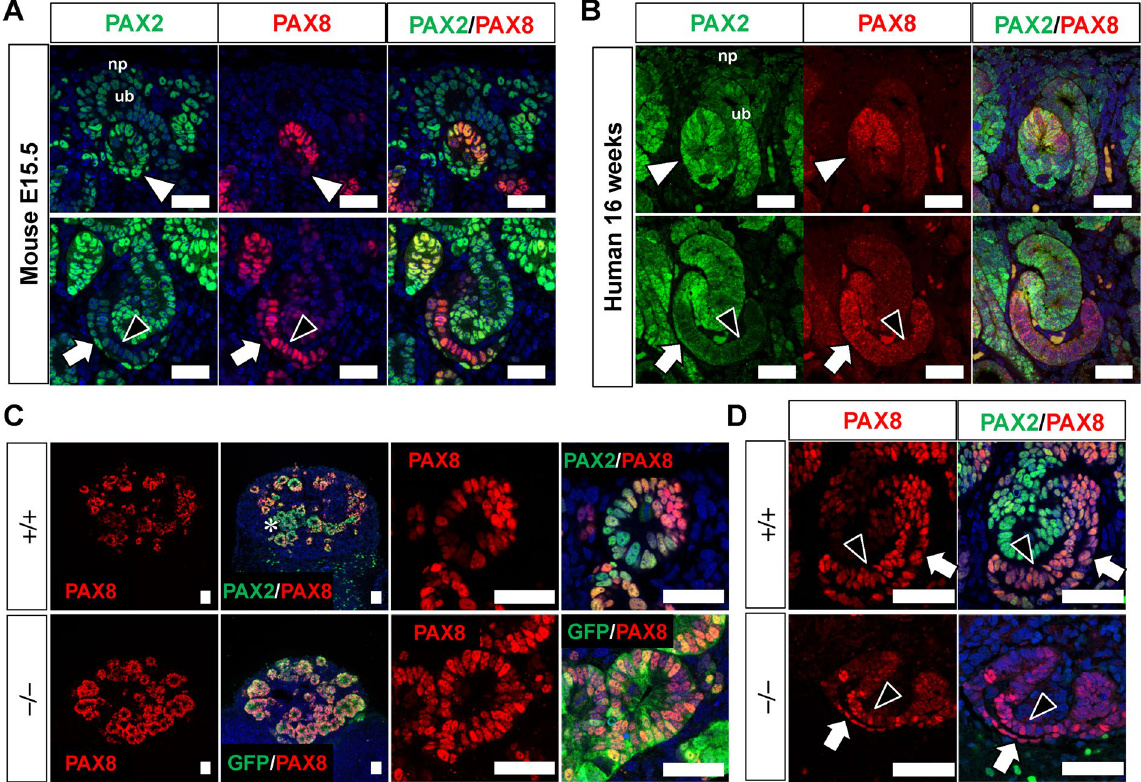
Figure 6. PAX8 expression domains are expanded in PAX2 -null human renal vesicles. ( A ) Expression of PAX2 and PAX8 in the mouse kidney at E15.5. Upper panels: renal vesicles; lower panels: S-shaped bodies. ( B ) Expression of PAX2 and PAX8 in the human kidney at 16 weeks of gestation. Upper panels: renal vesicles; lower panels: S-shaped bodies. ( C ) Expression of PAX8 in renal vesicles induced from the wild-type and PAX2 - null iPS cells. In the latter case, GFP staining was used to identify the cells that should have expressed PAX2. Note that PAX8 is expressed in most of the GFP + epithelia, while PAX2 + /PAX8 − vesicles were detected in the wild-type epithelia (asterisk). ( D ) Expression of PAX2 and PAX8 in S-shaped bodies induced from the wild-type and PAX2 -null iPS cells. White arrowheads: renal vesicles; arrows: precursors of glomerular parietal epithelia; black arrowheads: precursors of podocytes. np: nephron progenitors; ub: ureteric bud. Scale bars: 50 µ